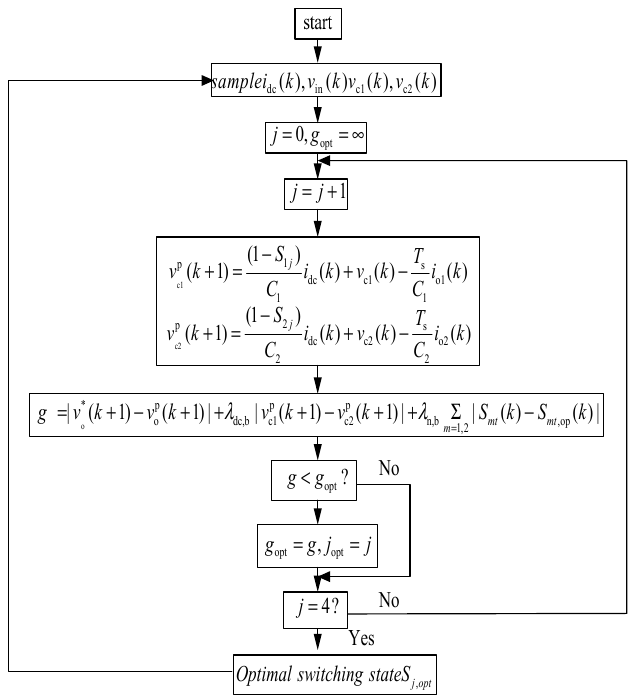
Figure 10. The cost function flow chart of the T-type inverter model prediction control algorithm.